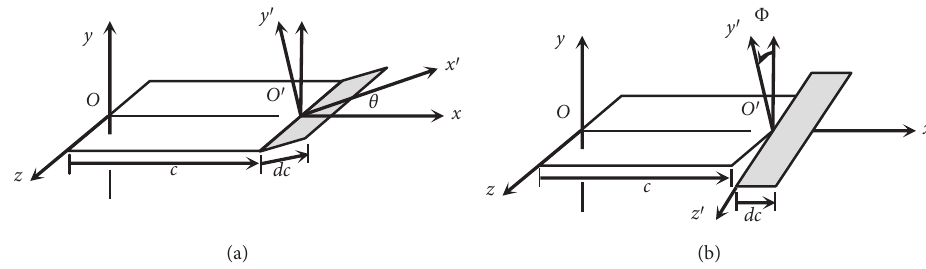
Figure 12: Nonplanar propagation mode of crack. (a) Crack surface deflection; (b) crack surface torsion.